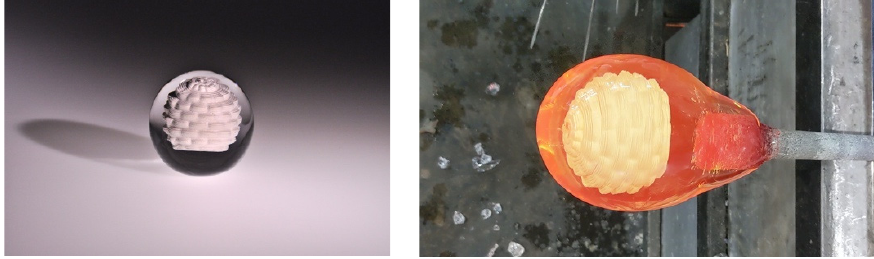
Figure 15. Suon and Callahan, research sample, pre-fired 3D printed ceramics encapsulated inclusion within hot glass, 2016, used with permission.